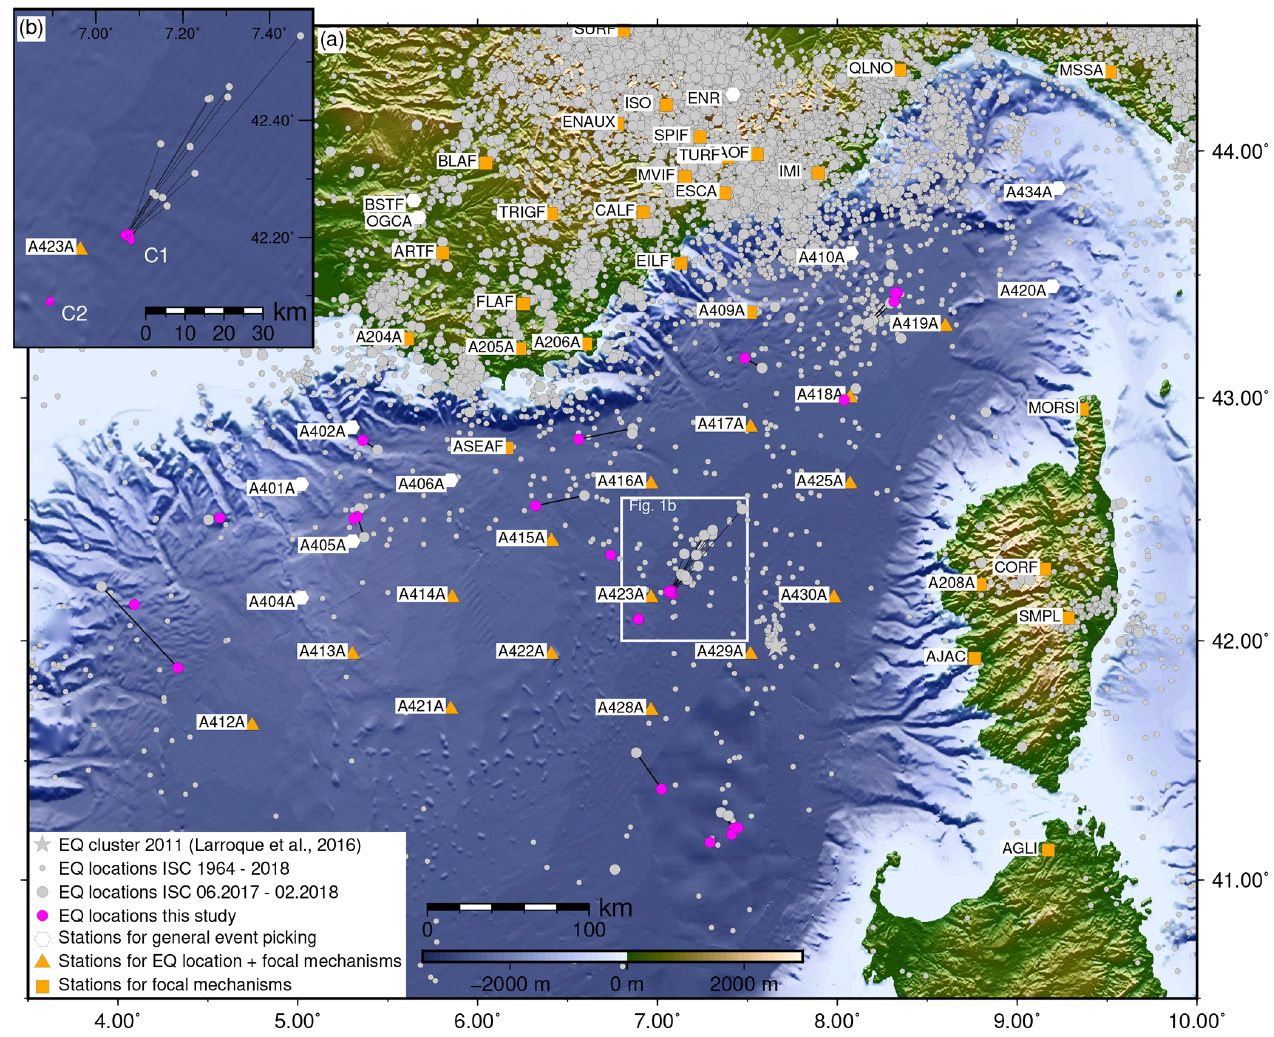
Figure 1. Topographic map of (a) the Ligurian Sea and (b) the area where the cluster events occurred (GMRT data, Ryan et al., 2009). Grey circles mark the epicentres of earthquakes from the ISC bulletin (Storchak et al., 2017). Magenta circles mark the epicentres of earthquakes within the Ligurian Basin observed in this study. Black lines connect locations of the same events found in both the ISC bulletin and this